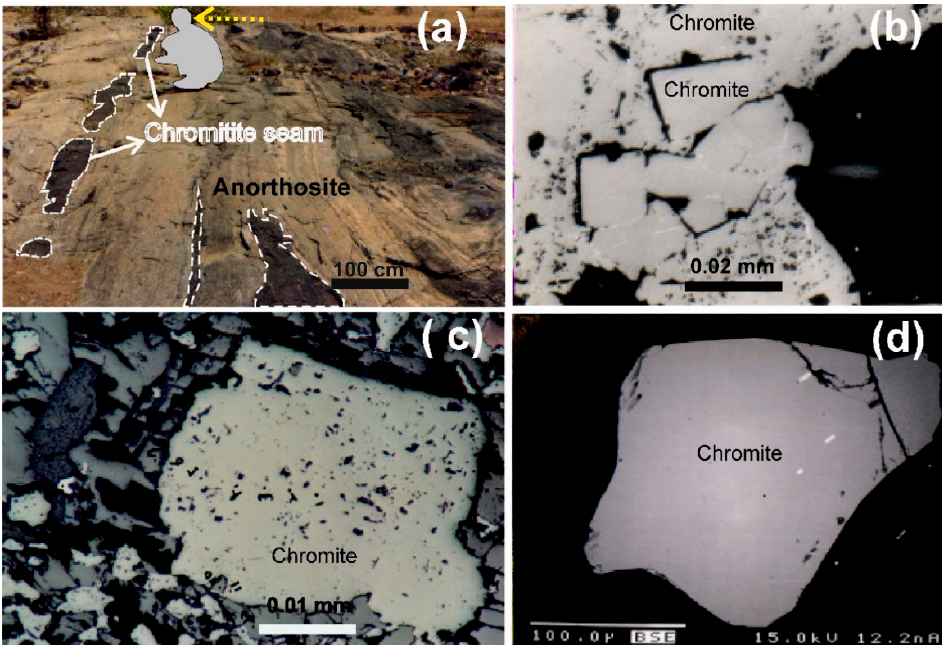
Figure 2. ( a ) Field photograph of discontinuous chromite seam hosted by meta-anorthosite. Person is for reference; ( b ) photomicrograph of polygonal faceted chromite grains within non-porous chromite; ( c ) chromite grains with silicate inclusions surrounded by intercumulus amphiboles; ( d ) back ‐ scattered electron image of a representative chromite grain; exsolved rutile needles are seen as white needles.